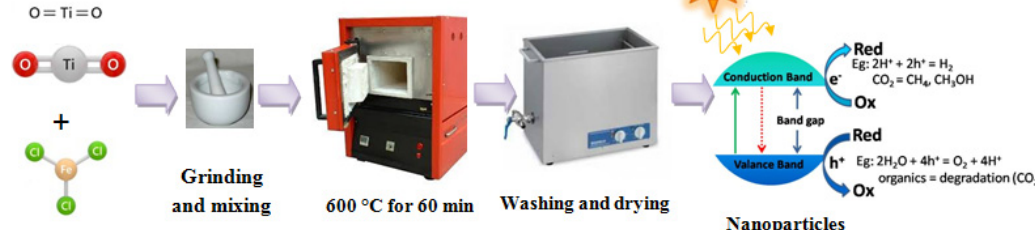
Fig. 1. The schematic of the preparation process of TiO Figure 1. The schematic of the preparation process of TiO 2 nanoparticles